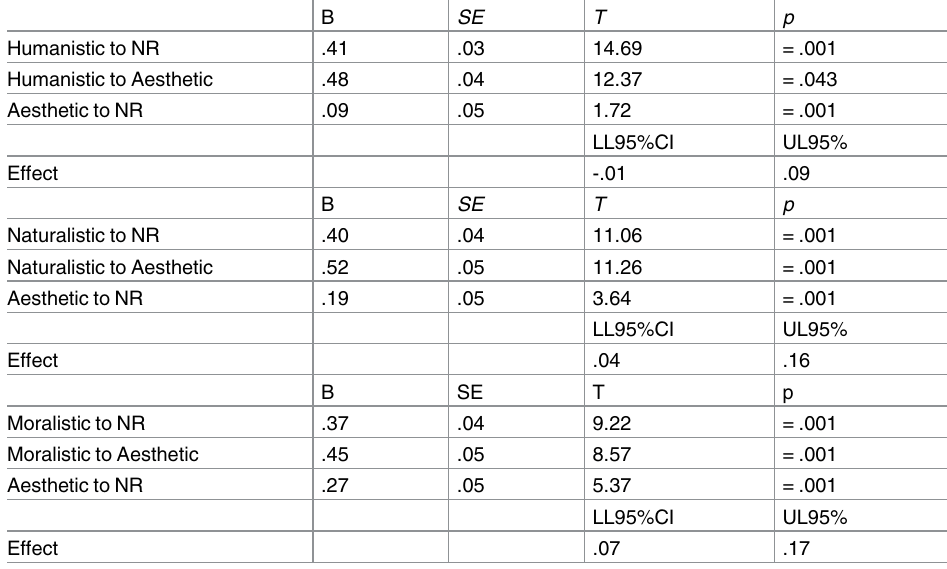
Table 7. Simple mediation of the indirect effectsof valuing humanistic, naturalistic and moralistic val- ues on nature connectedness (N = 203; 5000 bootstrap samples). B SE